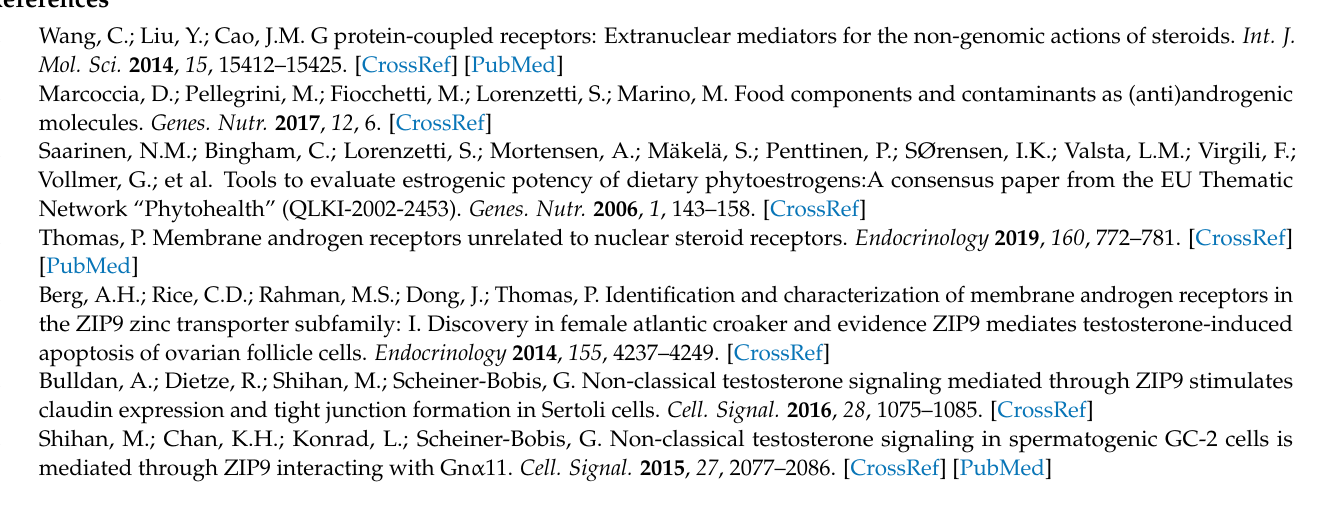
nuclear receptors, Figure S2: Ramachandran plot for ZIP9 model, Figure S3: Ramachandran plot for GPRC6A model, Figure S4: Ramachandran plot for OXER1 model, Figure S5: Ramachandran plot for TRPM8 model, Figure S6: Ramachandran plot for GPER model, file with the generated models for membrane receptors